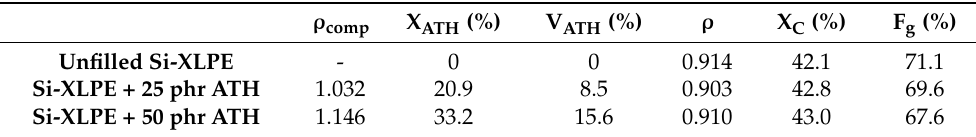
Table 1. Physico-chemical properties of the as-received materials and their Si-XLPE matrix, where ρ comp , X ATH , and V ATH are the density, mass, and volume fraction, respectively, of ATH in the composite materials. In addition, ρ , X C , and F g are the density, crystallinity ratio, and gel content, respectively, of the Si-XLPE matrix. ρ